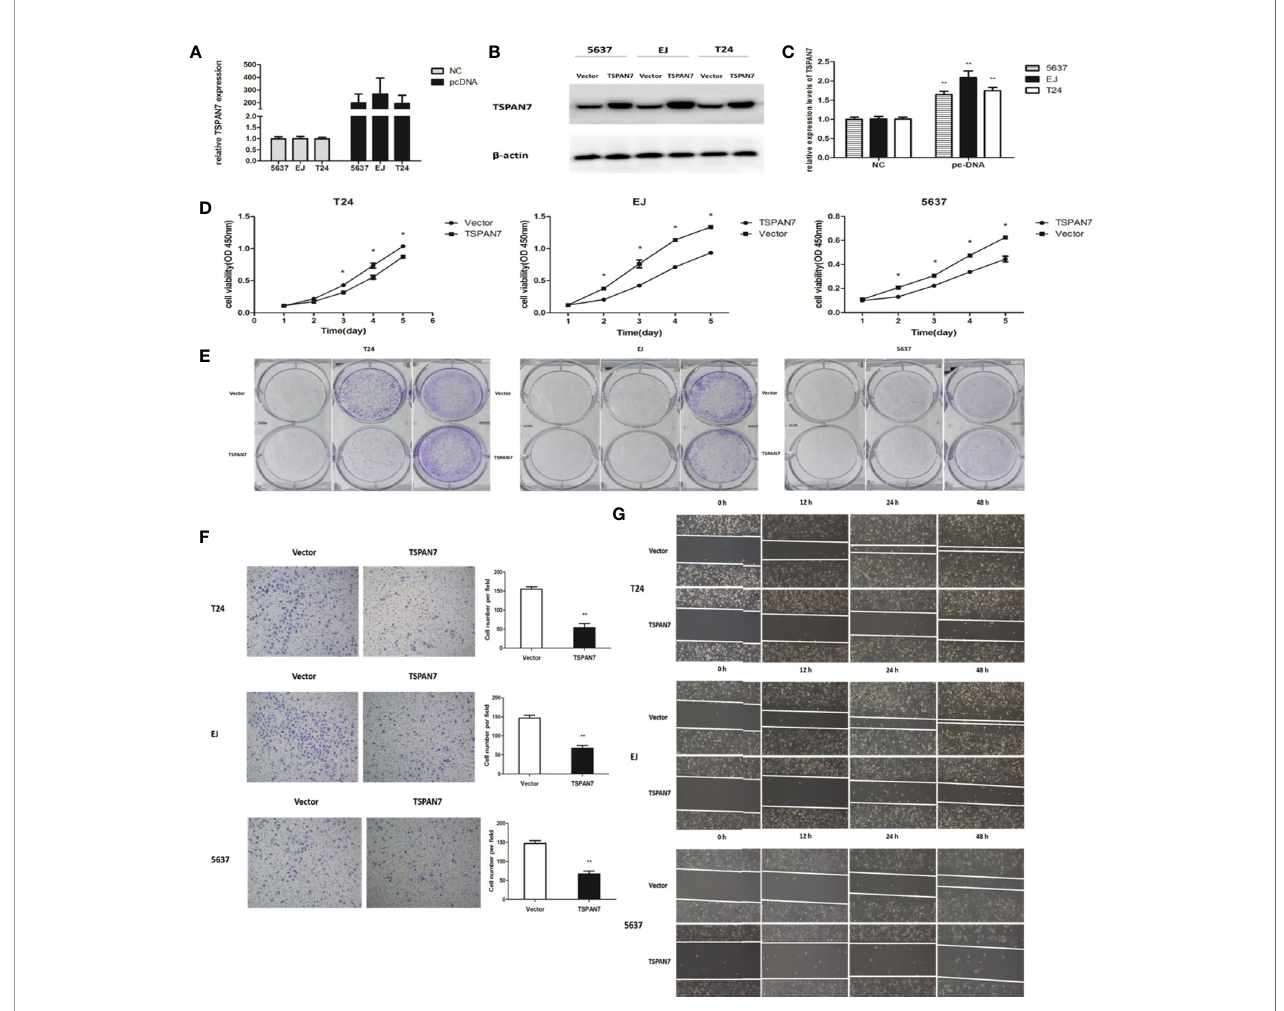
FIGURE 4 | Overexpression of TSPAN7 repressed BCa cell proliferation and migration. (A) Veri fi cation of TSPAN7 overexpression ef fi cacy at the mRNA level in T24, EJ, 5637 cells. (B, C) Veri fi cation of TSPAN7 overexpression ef fi cacy at the protein level in T24, EJ, 5637 cells. CCK-8 assays (D) and colony formation assays (E) showed that TSPAN7 overexpression decreased the proliferation capacity. Transwell invasion (F) and wound-healing assays (G) showed that TSPAN7 overexpression attenuated cell migration ability *P < 0.05; **P <